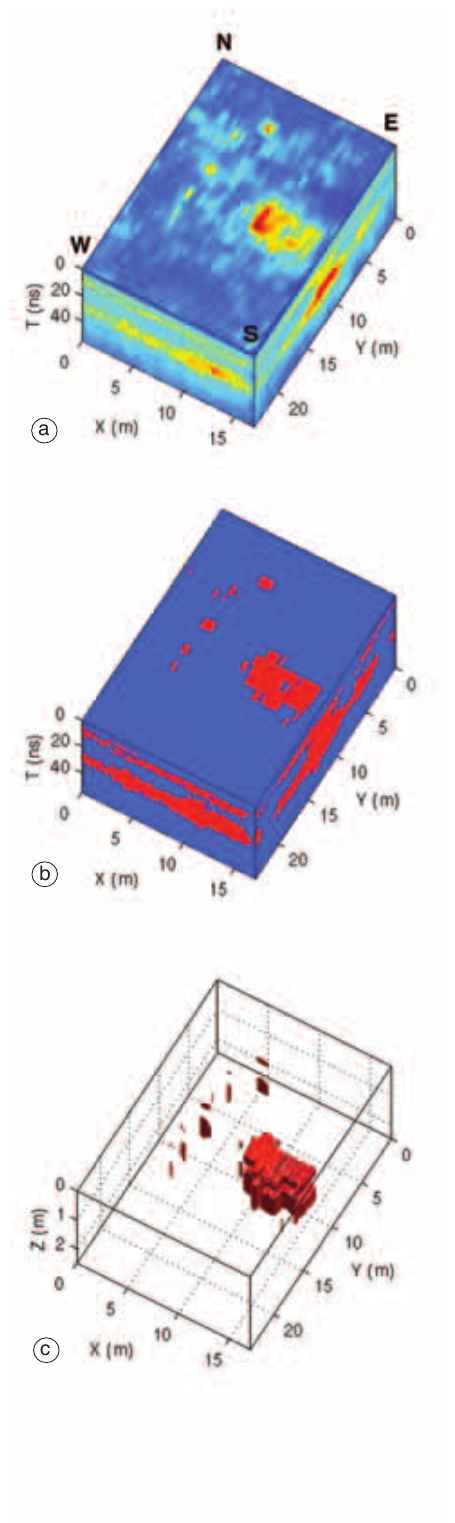
Fig. 7a-c. Zone D. 3D visualization by means of a procedure consisting of: complex attribute extraction, thresholding and 3D rendering. Energy stack on top and envelope stack on lateral sides (a), thresholding (b) and 3D rendering